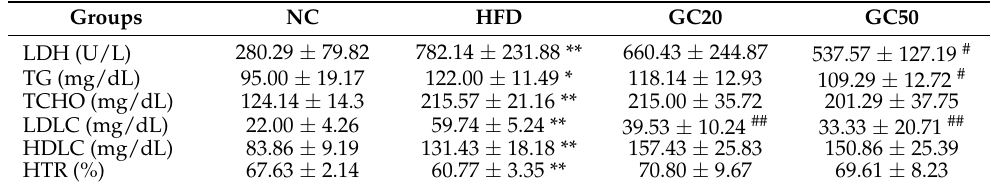
Table 3. Effect of 80% ethanolic extract from Gimcheon 1ho (GC) cultivar walnut ( Juglans regia ) on serum